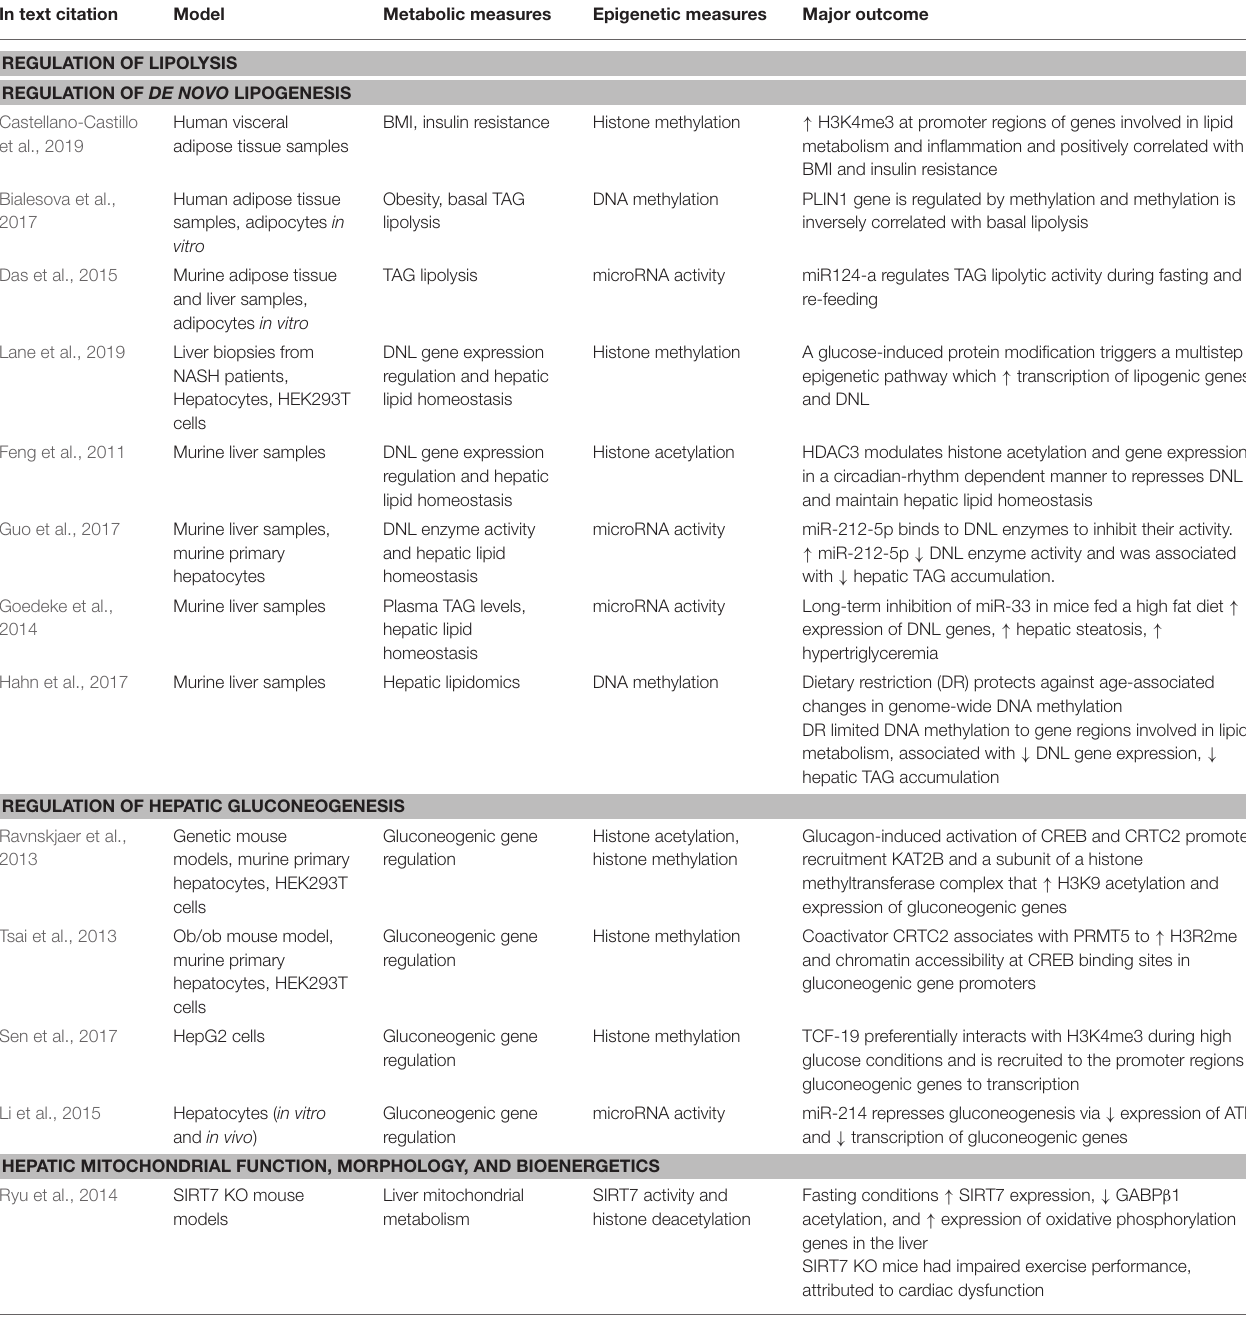
TABLE 1 | The 13 studies that met the inclusion criteria of original research available in English completed between 2010 and 2020 examining metabolism-modulated epigenetic changes in liver and adipose